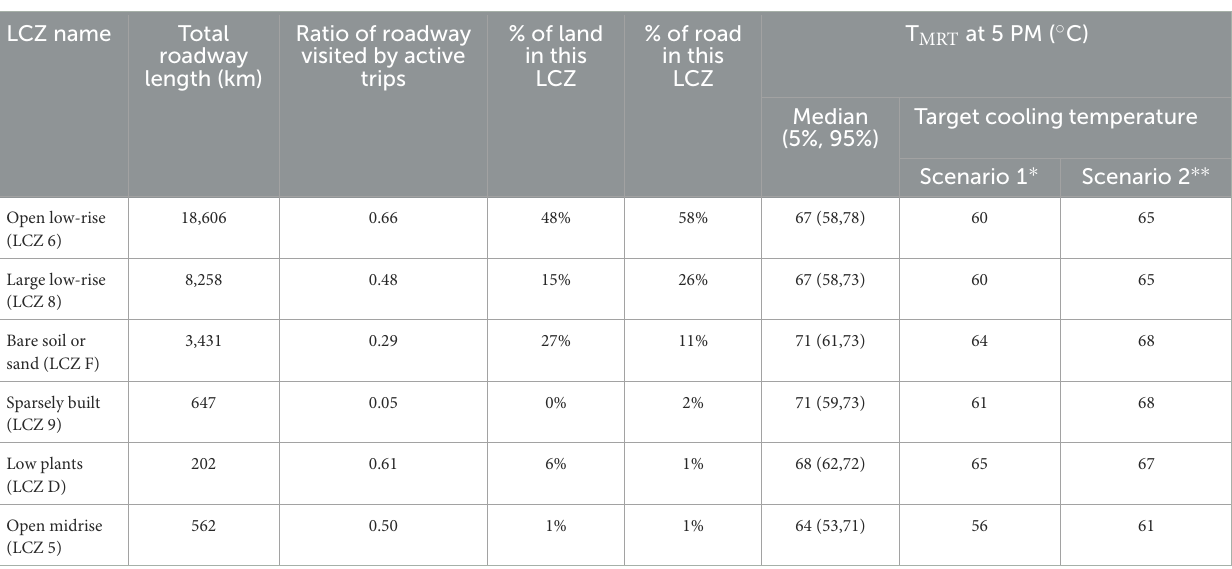
TABLE 1 Proportion of land, corridors, current, and target T MRT in each